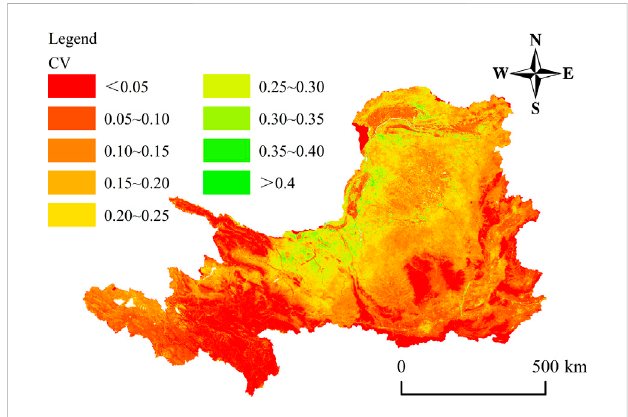
FIGURE 4 Spatial distribution of the coef fi cient of variation.